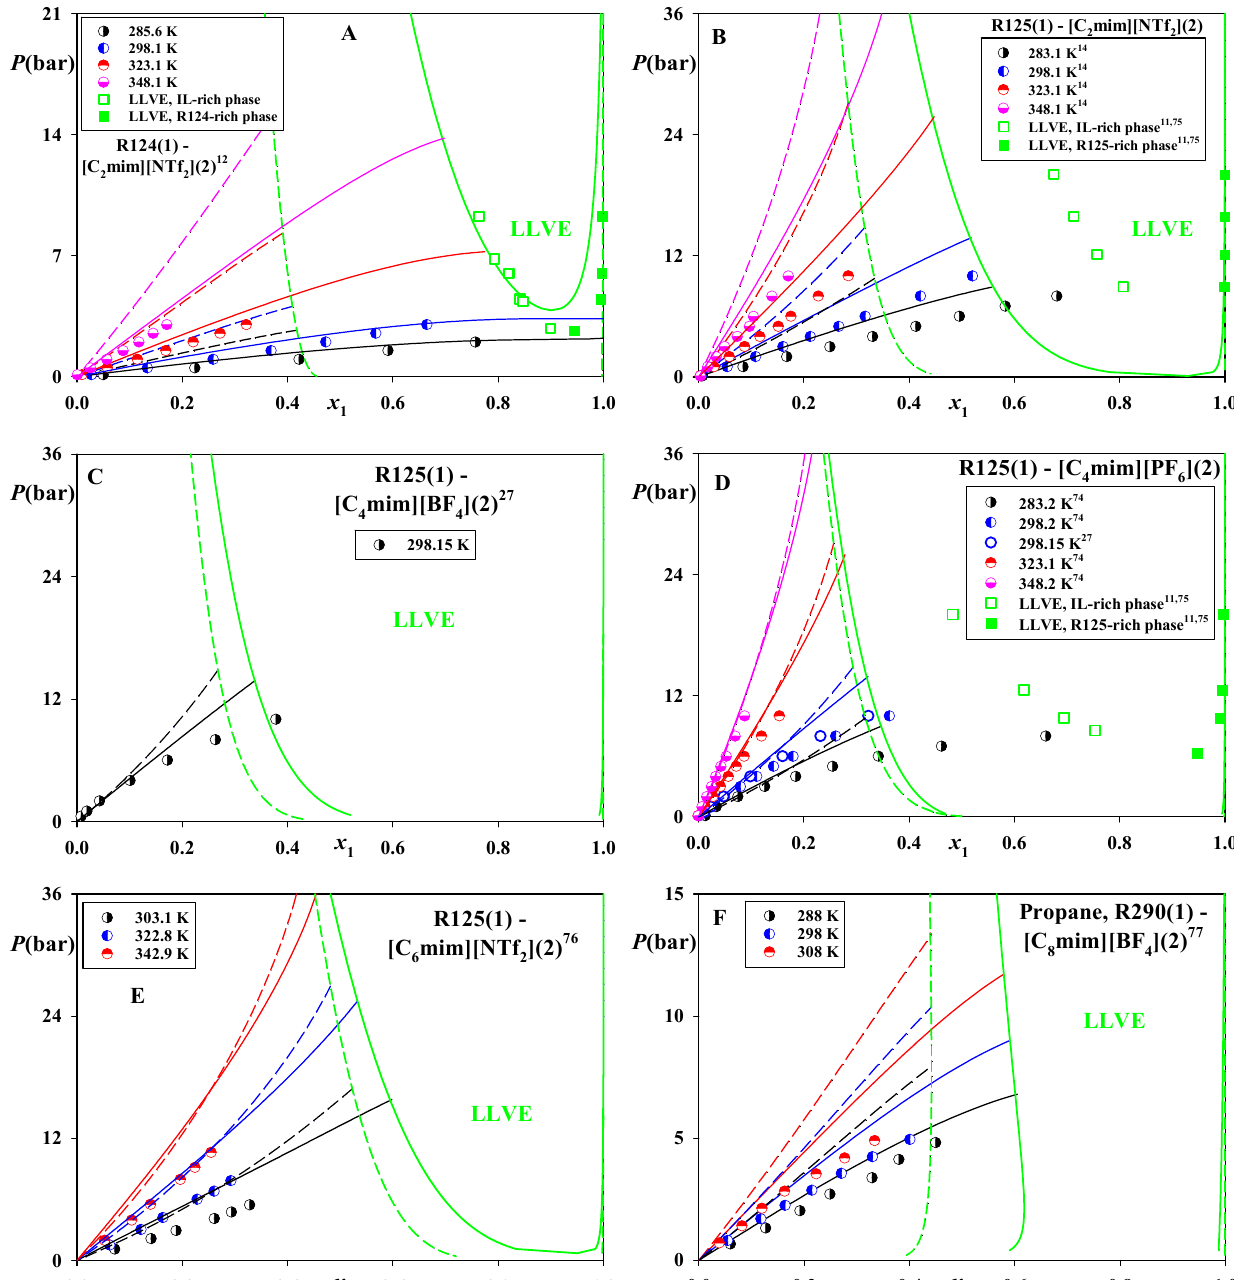
Figure 3. Phase equilibria in the systems of R124, R125, and propane (R290) dissolved in [C 2 mim][NTf 2 ], [C 6 mim][NTf 2 ], [C 4 mim][BF 4 ], [C 8 mim][BF 4 ] and [C 4 mim][PF 6 ]. Points — experimental data [11,12,14,27,75,76,77]. Solid lines — predictions of CP-PC-SAFT, dashed lines — predictions of SAFT-VR-Mie. k 12 = 0 for both models.